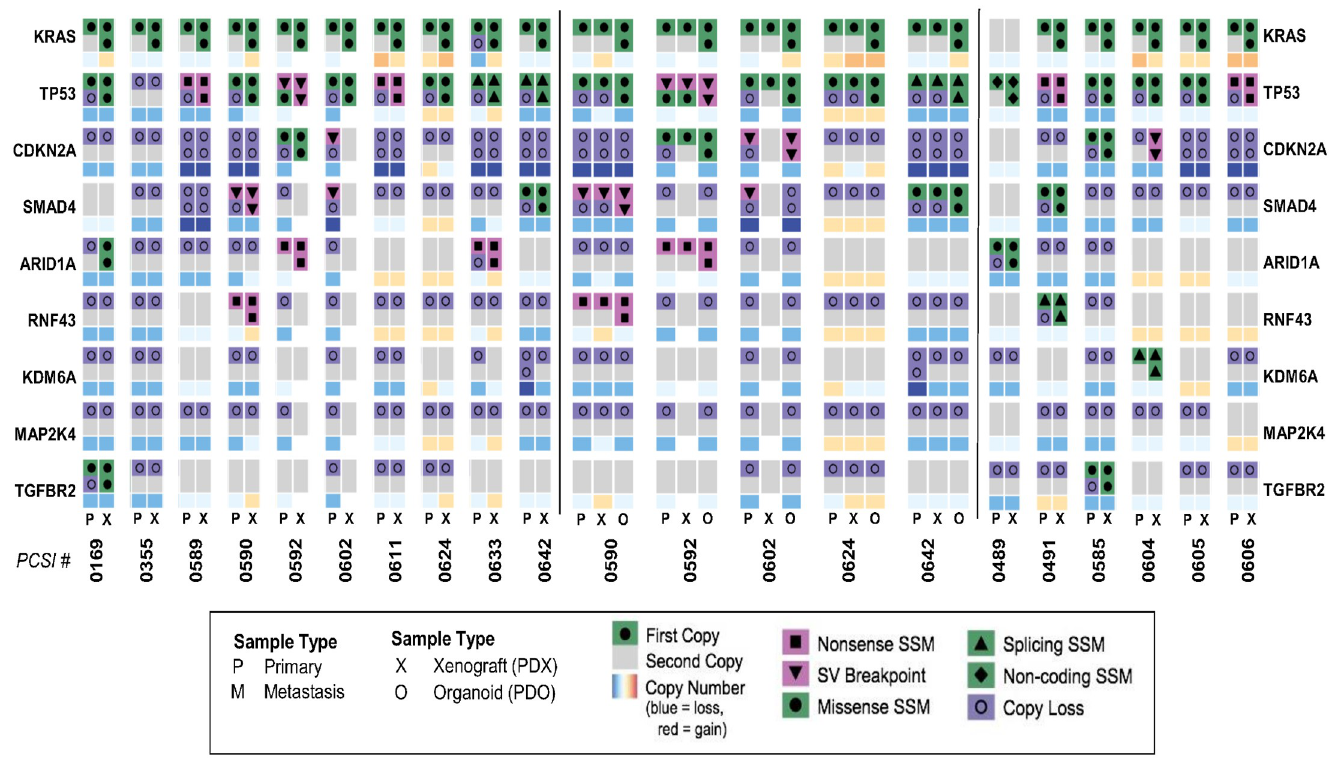
Fig 3. Comparative analysis of SSM, SV, and CNV across genes of PDAC tumourigenesis and disease therapy. The genomic profile of driver genes across primary- PDX pairs (left), metastasis-PDX pairs (left), and primary-PDX-PDO trios (middle) is shown.